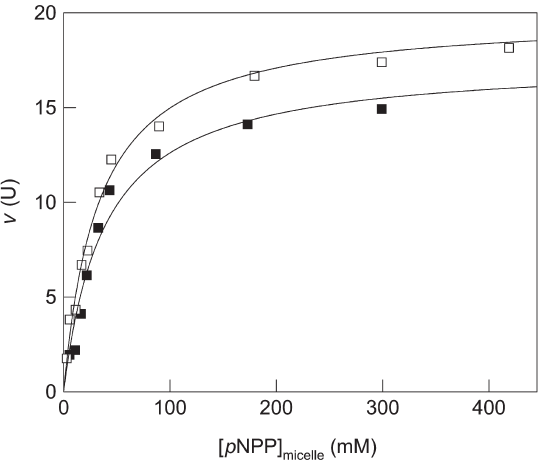
Figure 1. Plots of p NPPase activity in reverse micelles at low salt con- centration (0.048 M NaCl; (cid:2) ) and at high salt concentration (0.85 M NaCl; (cid:3) ). Final conditions: aqueous buffer 100 mM Tris-HCl, pH 8.5 containing 20 mM 2-mercaptoethanoland 5 mM MnCl 2 with 0.048 or 0.85 M NaCl; w 0 = 10.27 at 40 °C, with different concentrations of p NPP ranging from 2.5 to 418 mM. Protein concentration was 0.6 µg ml –1 .